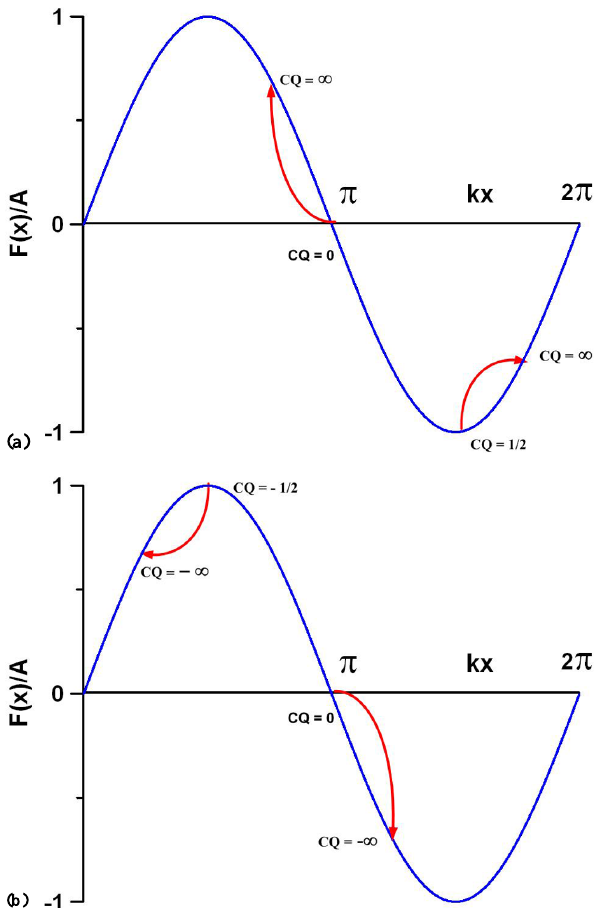
Fig. 2. As one may expect, positive cubic nonlinearity decreases the breaking time. Negative cubic nonlinearity decreases the absolute value of local nonlinear speed which also decreases the breaking time. Even more, the total breaking time is a function of |CQ| only.